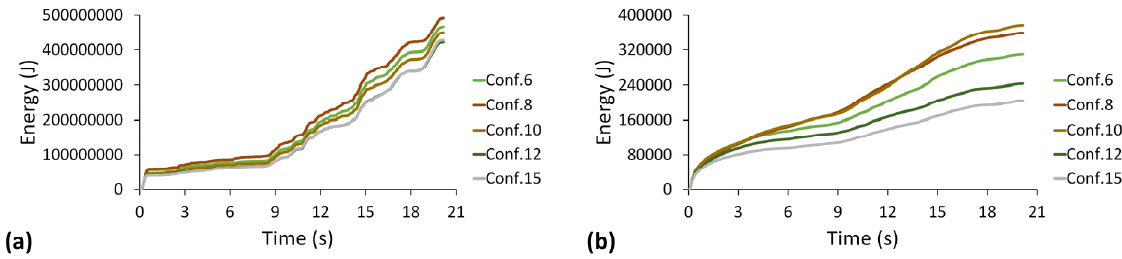
Figure 14. Seismic performance of different infill panels in the configurations under the Nahanni earthquake: ( a ) plastic dissipation and ( b ) viscous dissipation . earthquake: ( a ) plastic dissipation and ( b ) viscous